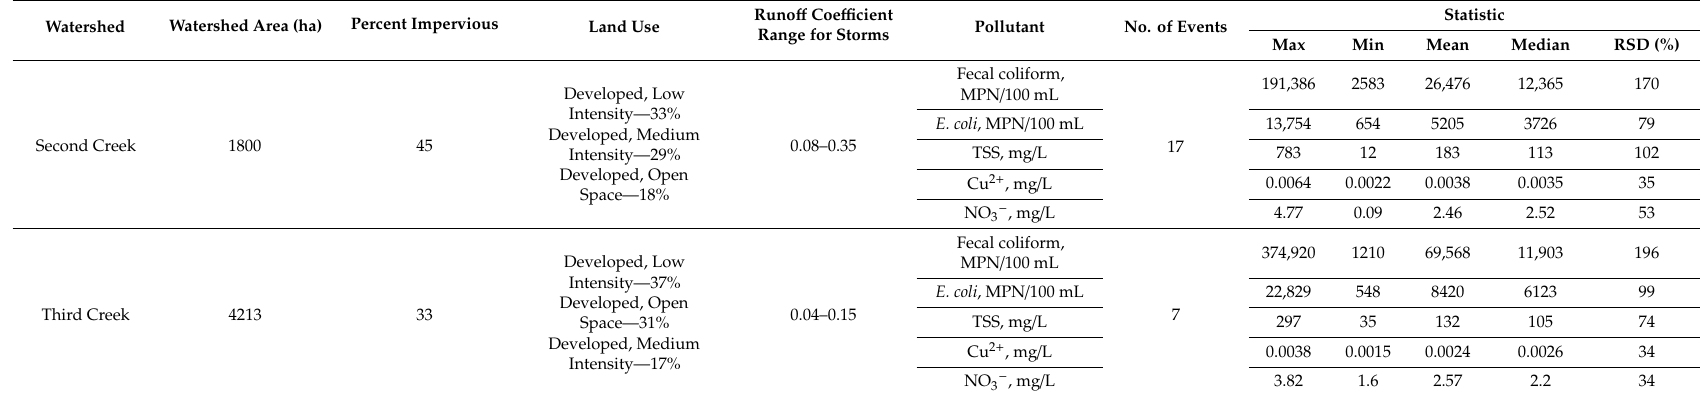
Table 1. Watershed characteristics and summary Event Mean Concentration (EMC) statistics: maximum, minimum, mean, median, and relative standard deviation (RSD) for fecal coliform, Escherichia coli ( E. coli), total suspended solids (TSS), Cu 2 + , and NO 3 −